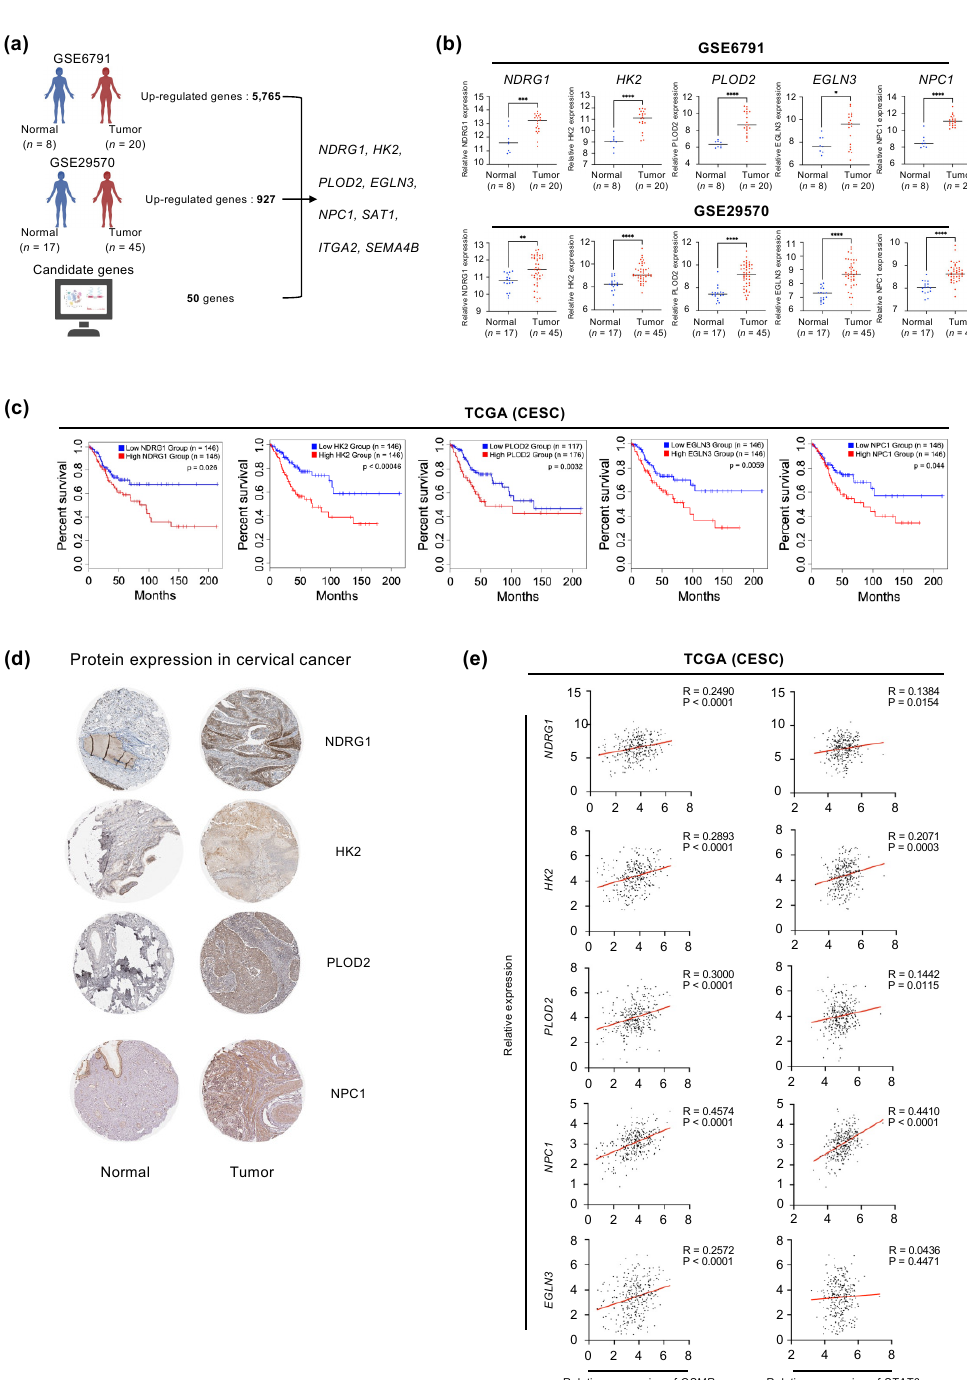
Figure 6. Identification of the gene signature induced by OSM-STAT3 in human cervical cancer patients. ( a ) Schematic diagram: Using publicly available microarray datasets GSE6791 and GSE29570. The schematic diagram was expressed through BioRender (https://biorender.com/ (accessed on 20 October 2022)). ( b ) Comparison of NDRG1 , HK2 , PLOD2 , EGLN3, and NPC1 expression levels between normal cervix tissues and cervical cancer tissues; * p < 0.05, ** p < 0.01, *** p < 0.001, **** p < 0.0001. ( c ) Kaplan–Meier curves showing overall survival for cervical SCCs with high vs low expression of five genes, as determined from GEPIA2 database. ( d ) NDRG1, HK2, PLOD2, and NPC1 proteins were upregulated in tumor tissues compared with normal cervix tissues according to the Human Protein Atlas database. ( e ) Simple linear regression analysis of expression levels of NDRG1 , HK2 , PLOD2 , NPC1, and EGLN3 versus OSMR and STAT3 in CESC from TCGA (n =